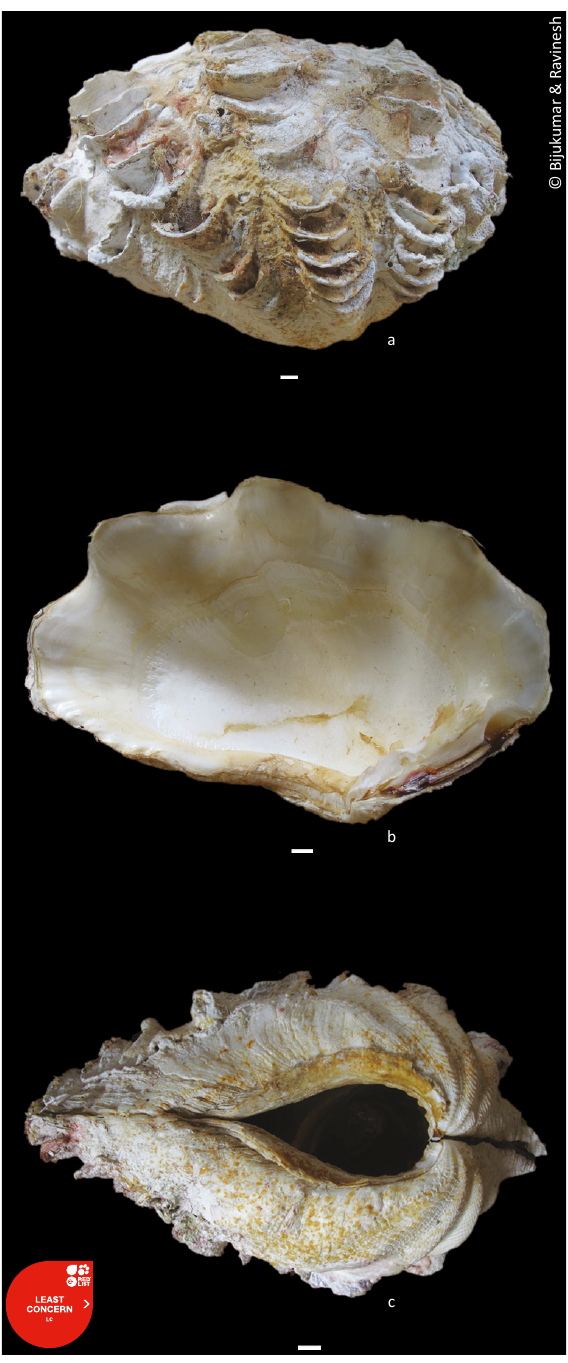
Image 12. Tridacna maxima Röding a - exterior of right valve; b - interior of left valve; c - ventral view showing byssal orifice (scale = 1cm)